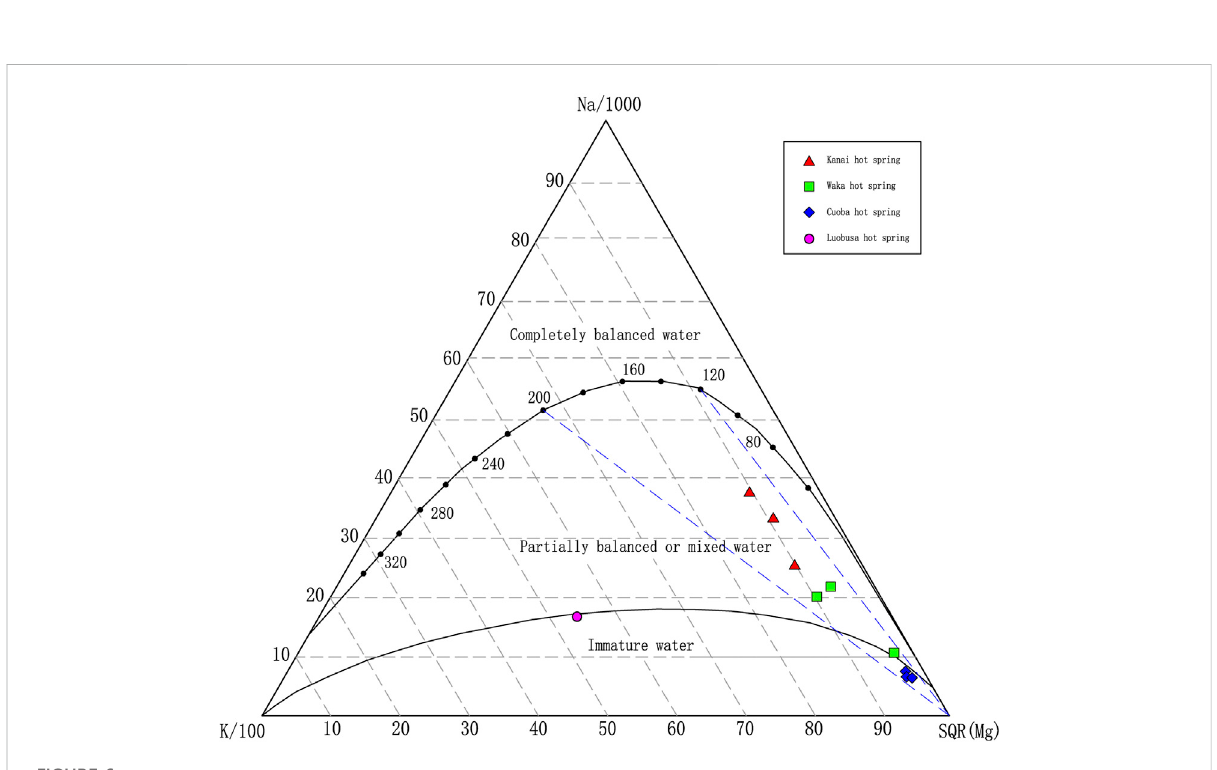
FIGURE 6 Na-K-Mg triangle diagram of geothermal